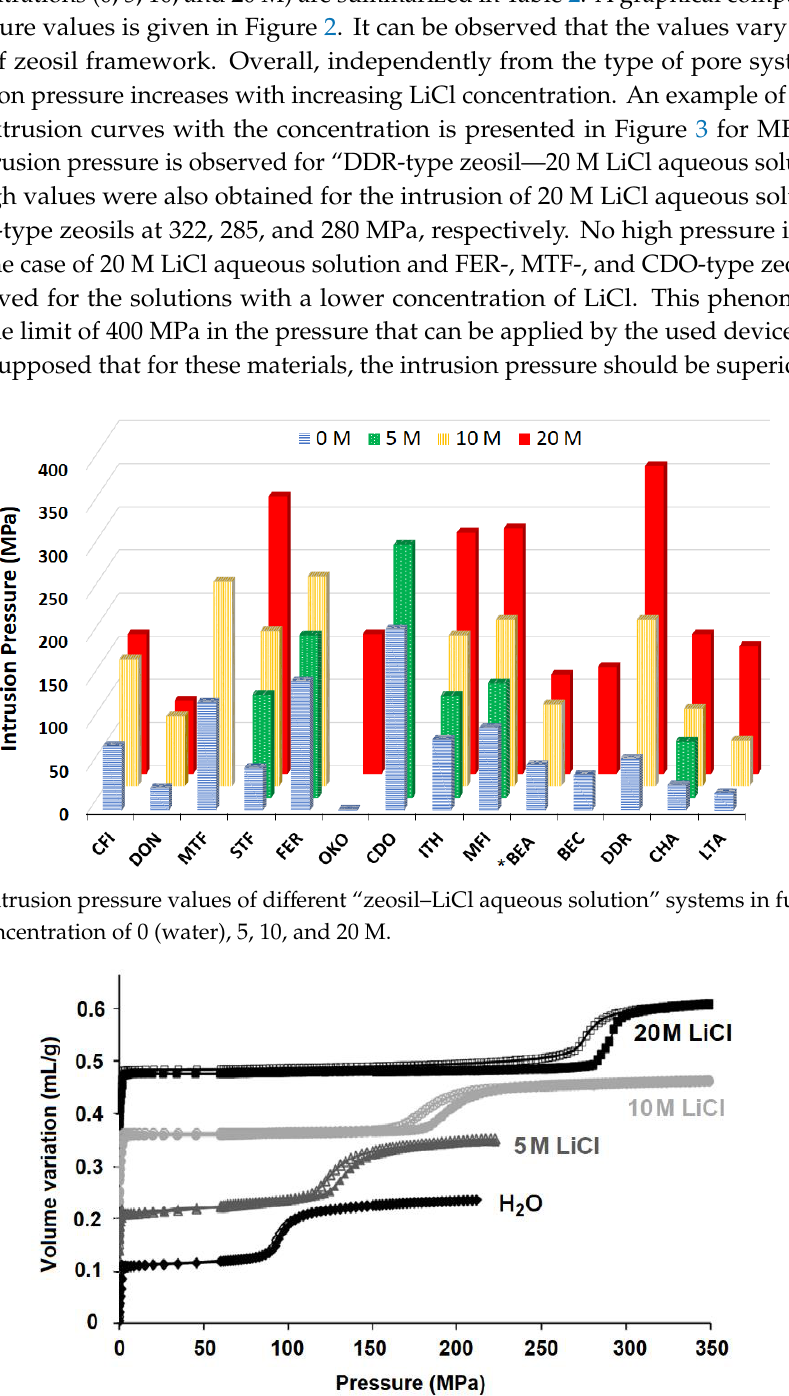
Figure 3. Intrusion–extrusion curves of “MFI-type zeosil–H 2 O” and “MFI-type zeosil–LiCl aqueous solution” systems. The results are taken from [47].